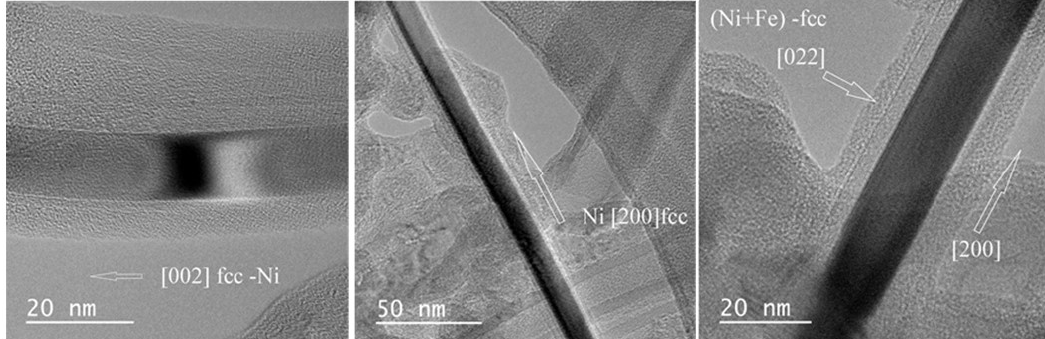
Figure 7. TEM images of single crystal metal (Ni or Ni + Fe) nanokernels grown inside nanotubes with [200] orientation along the nanotube axis. The left and central images show Ni monocrystals in di ff erent directions; the right image demonstrates Ni + Fe